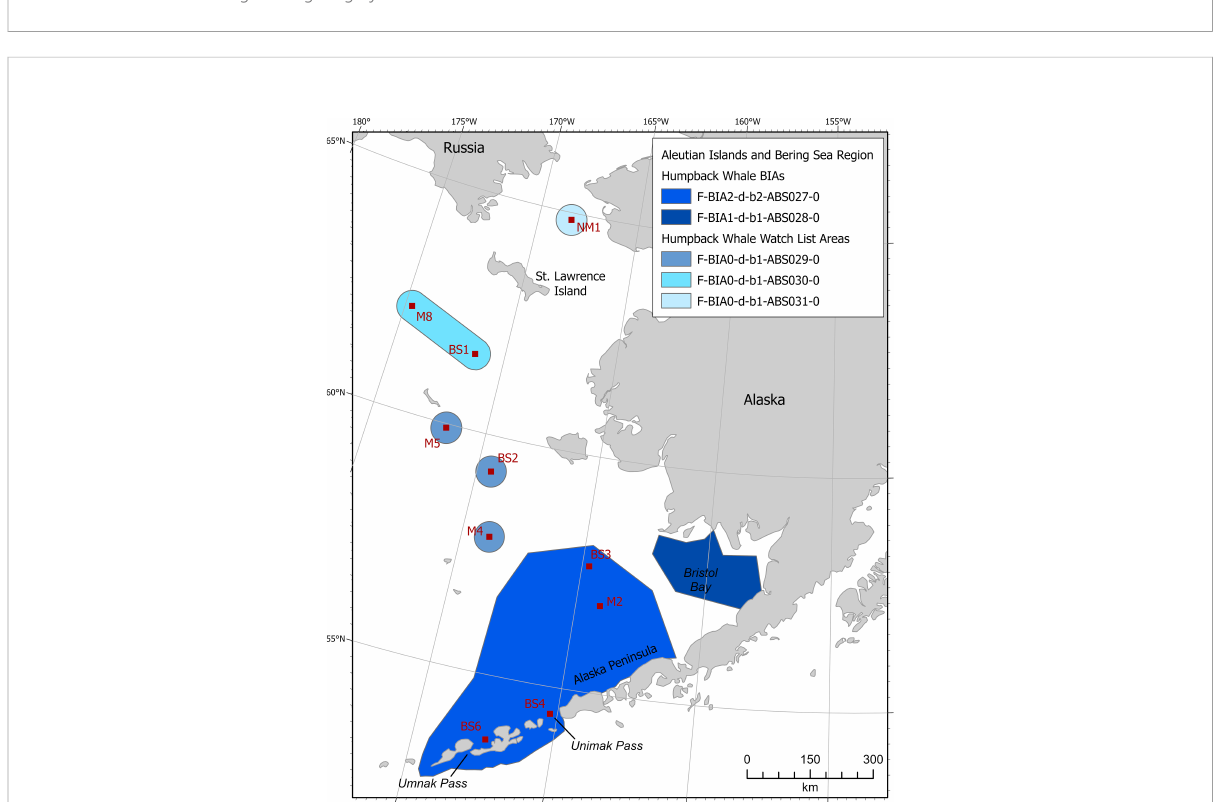
FIGURE 4 Aleutian Islands and Bering Sea region gray whale BIAs and watch list areas.